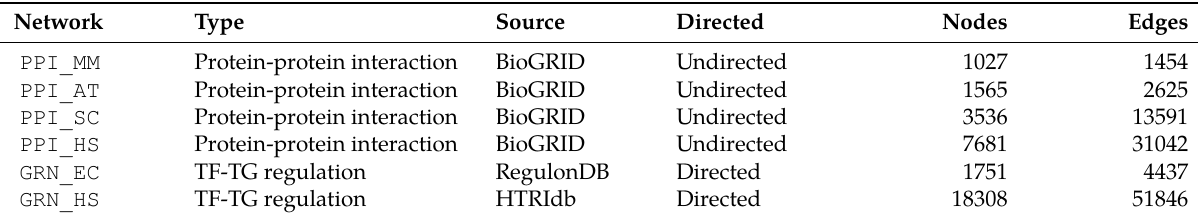
Table 1: Overview of network files used in benchmarks.